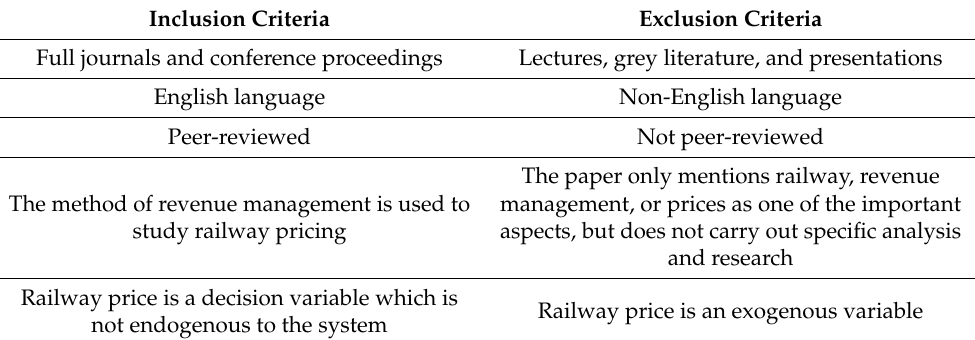
Figure 1. Literature selection process. Table 1. The inclusion and exclusion criteria .